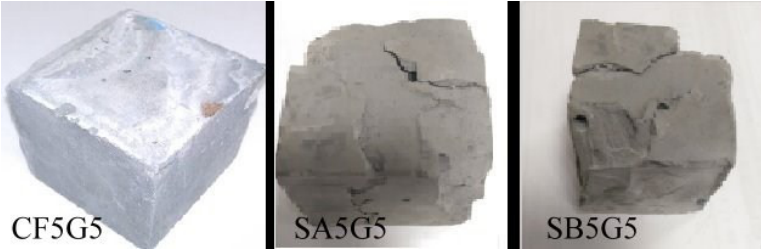
Figure 3. Images of CF5G5, SA5G5 and SB5G5 after compressive test. (CF5G5: 50% fly